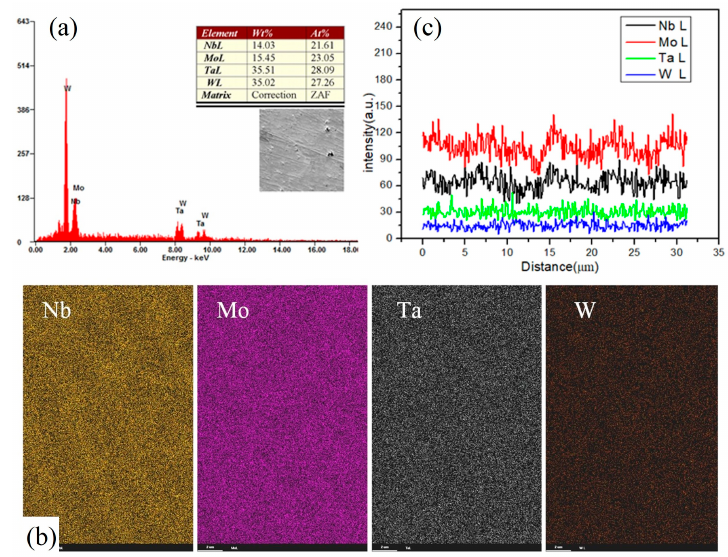
Figure 4. Results of composition analysis. ( a ) Composition distribution, ( b ) EDS analysis, ( c ) Composition distribution among micro grains.